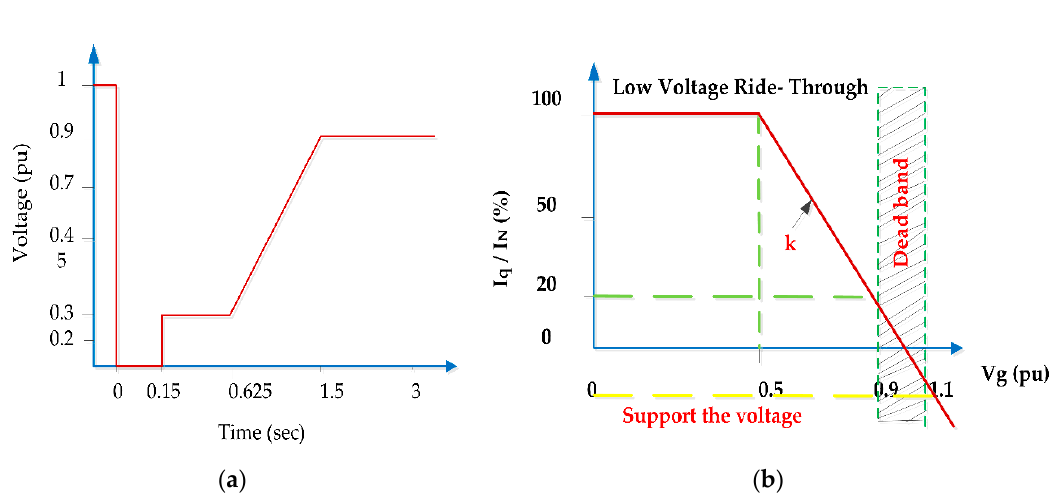
Figure 3. E.ON Netz GmbH code: ( a ) low voltage ride-through (LVRT) waveform and ( b ) reactive current injection requirement.